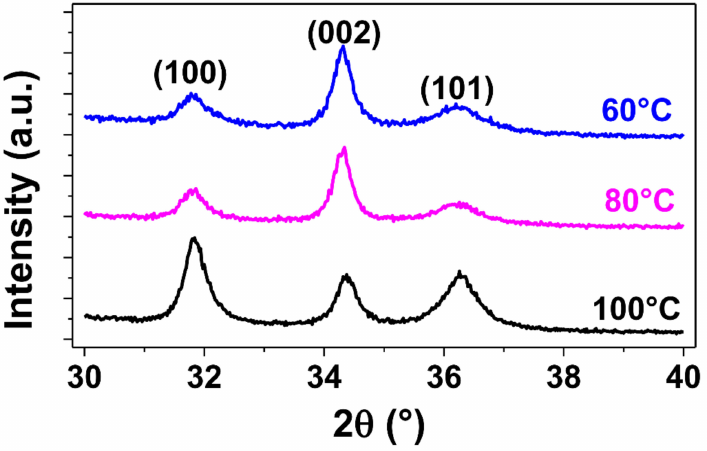
Figure 6. GI-XRD diffraction patterns ( ω = 0.3 ◦ ) of ZnO thin films grown on top of 75 µ m thick polyimide substrates at 100 ◦ C, 80 ◦ C and 60 ◦